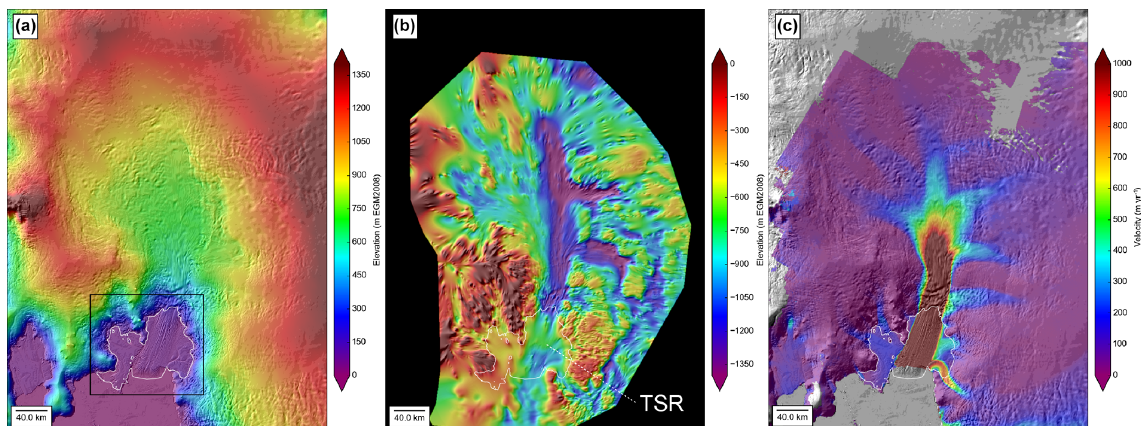
Figure 2. Context for the PIG catchment: (a) high-resolution WorldView/GeoEye DEM mosaic over Bedmap2 DEM. The white outline shows the PIG ice shelf and ∼ 2011 grounding line. The black box shows the location of Fig. 3. (b) Combined bed topography and bathymetry from anisotropic interpolation of radar-derived ice thickness and other sources (see Sect. 2.6). Note the bedrock channels beneath main trunk and tributaries. The dotted white line shows the location of the transverse seabed ridge (TSR) in the PIG ice shelf cavity (see Supplement Fig. S1 for detailed bed intercomparison). (c) Median 2006–2016 surface velocity magnitude with the color ramp saturated at 1kmyr − 1 to show detail over tributaries (see Fig. 1 of Shean et al., 2017, for the color ramp saturated at 4kmyr − 1 ).